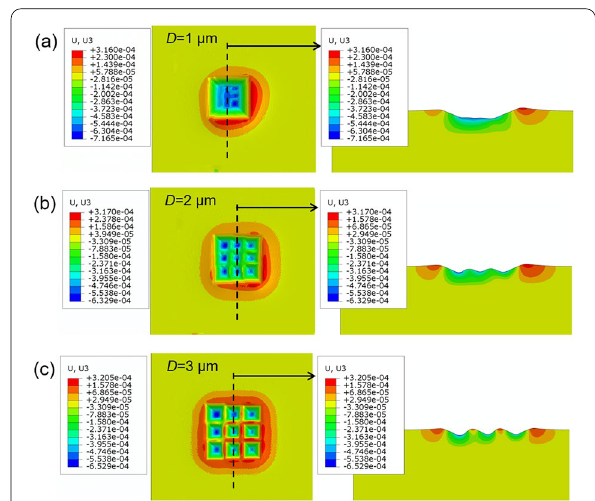
Figure 17 Top views and the corresponding cross-sections of the simulated results for the 3 3 indentation arrays with the rotation × angle of 45° and the spacings of a 1 μm, b 2 μm and c 3